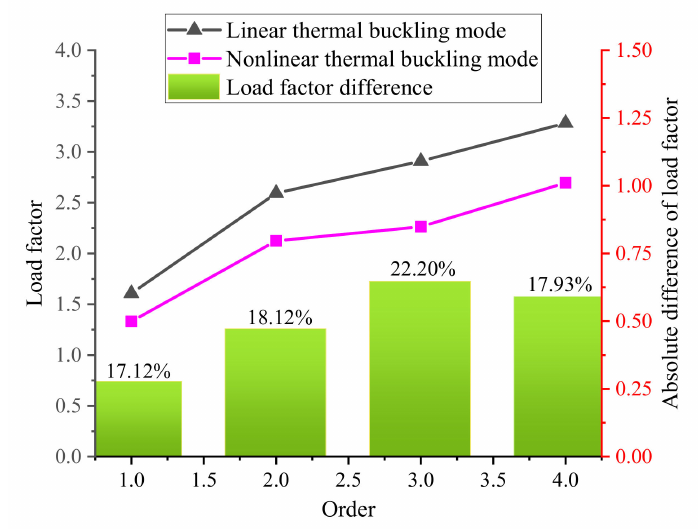
Figure 16. The load factors of two kinds of thermal